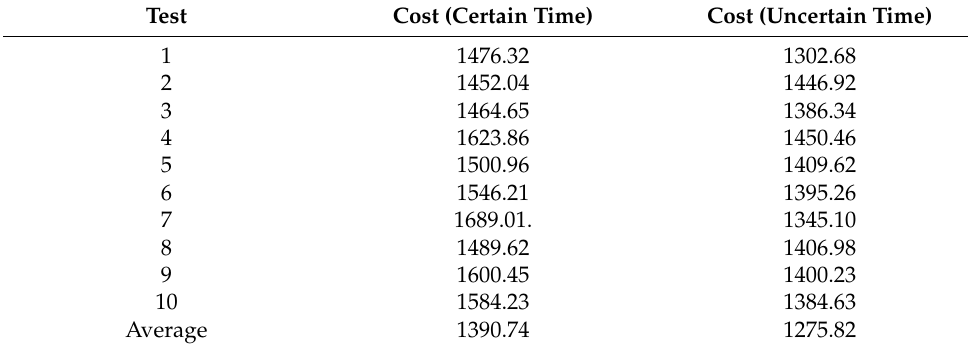
Table 9. Simulation results of